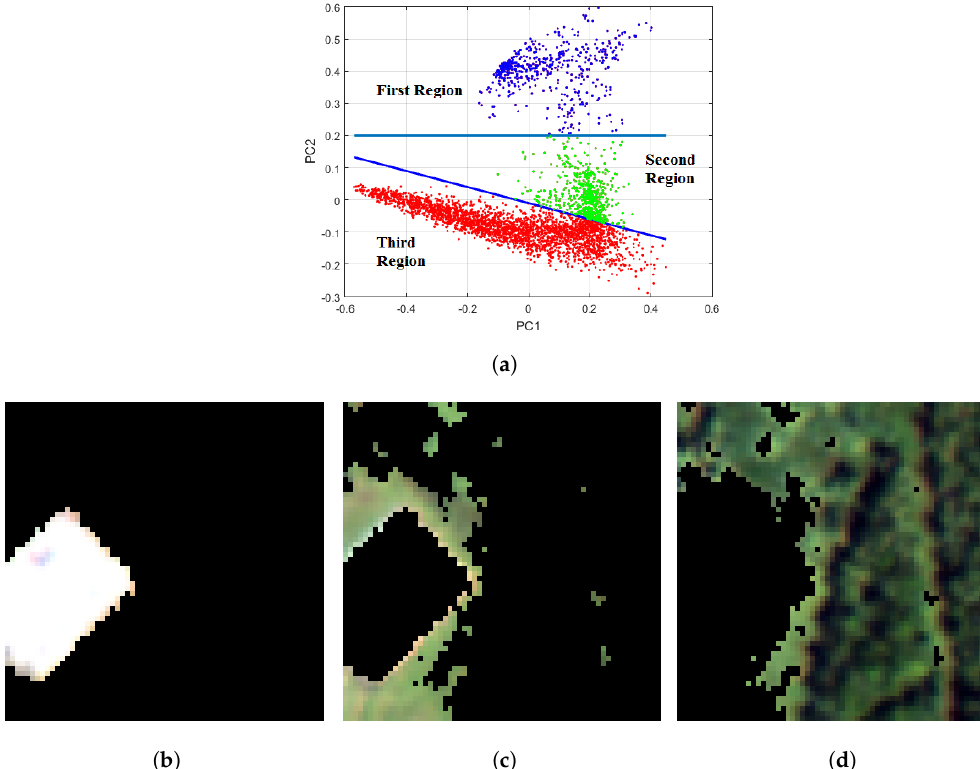
Figure 4. Relating spatial and spectral domains for Fort A.P. Hill image: ( a ) segmentation of the data cloud in feature space; ( b ) region 1 in the spatial domain (Gravel field); ( c ) region 2 in the spatial domain (Grass field); ( d ) region 3 in the spatial domain